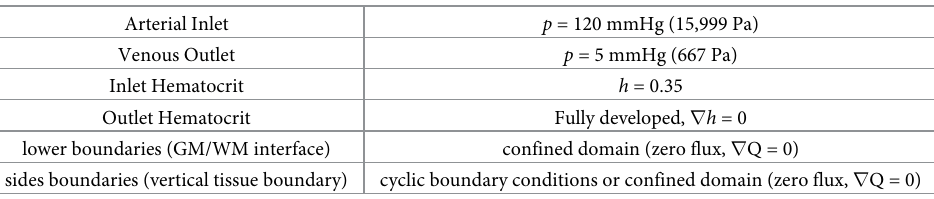
Table 3. Summary of boundary